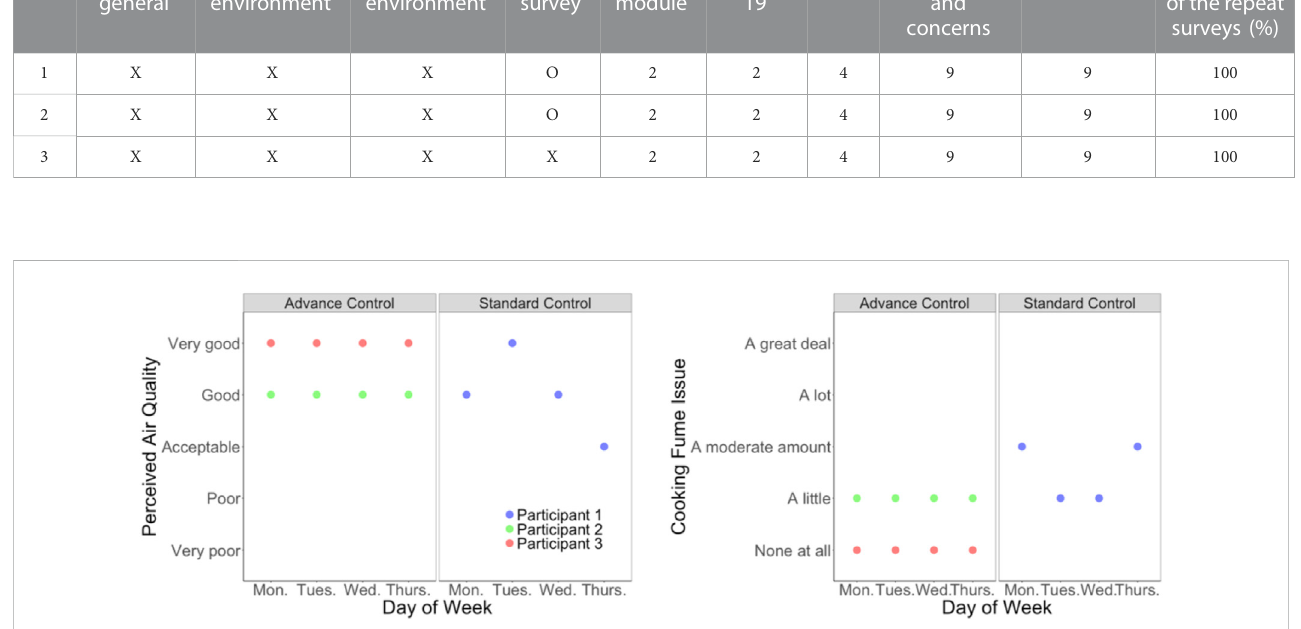
FIGURE 10 (A) Indoor air quality perception results and (B) cooking fume